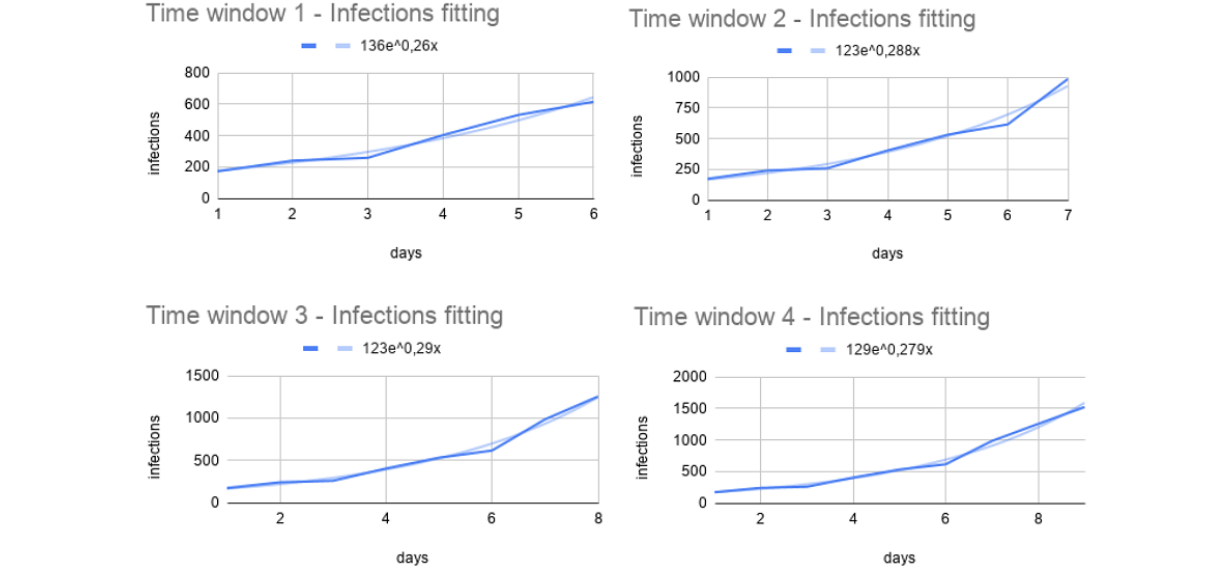
Figure 1. Exponential fitting of infection levels for the first four time windows. Each is longer than the previous by 1 day. The shown time windows are W1 (6 days), W2 (7 days), W3 (8 days), and W4 (9 days).